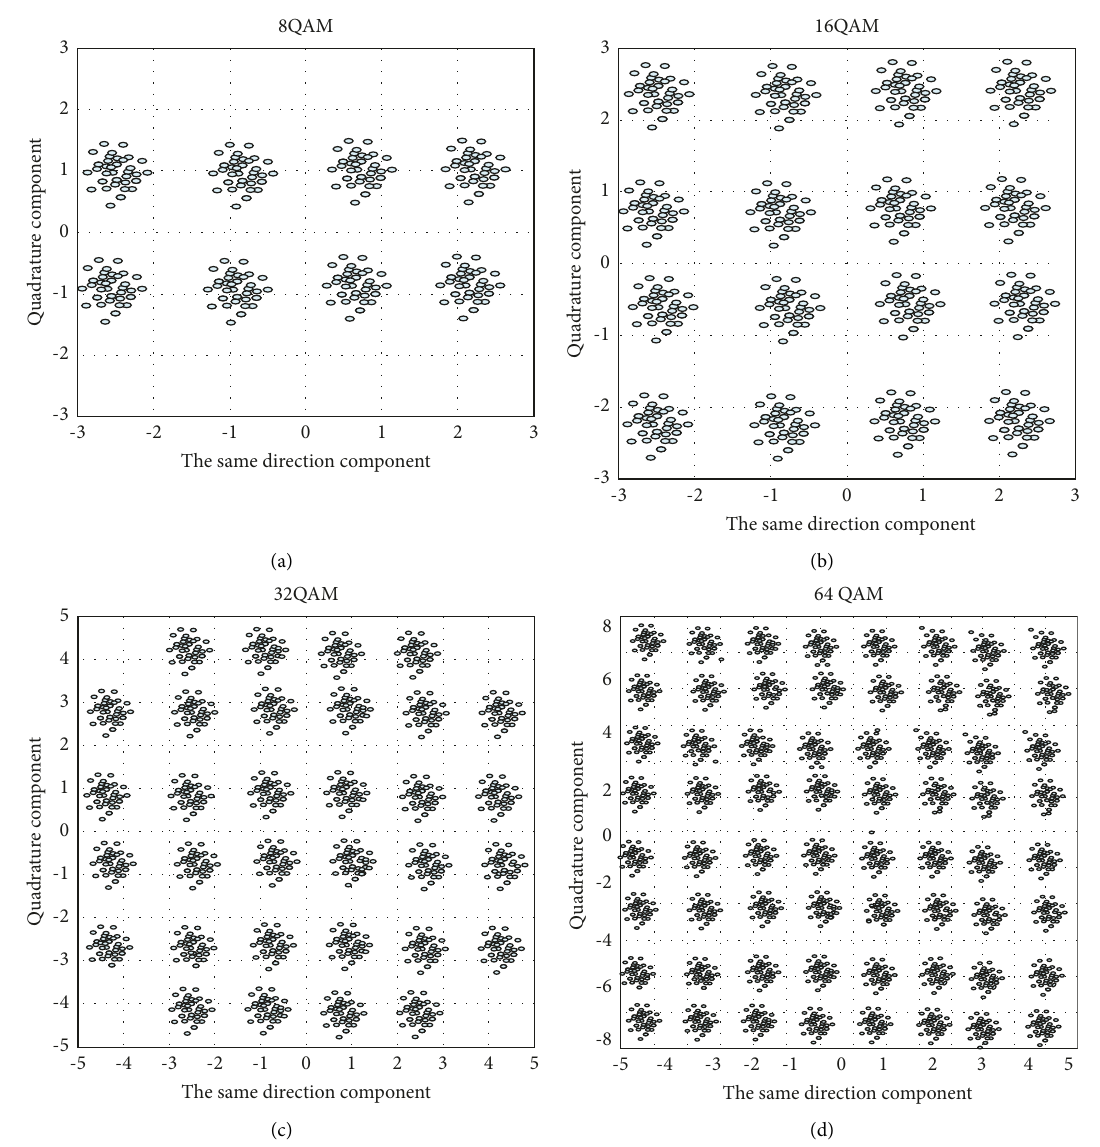
Figure 7: MQAM signal constellation diagram (SNR � 25dB): (a) 8QAM rectangular constellation diagram; (b) 16QAM rectangular constellation diagram; (c) 32QAM rectangular constellation diagram; (d) 64QAM rectangular constellation